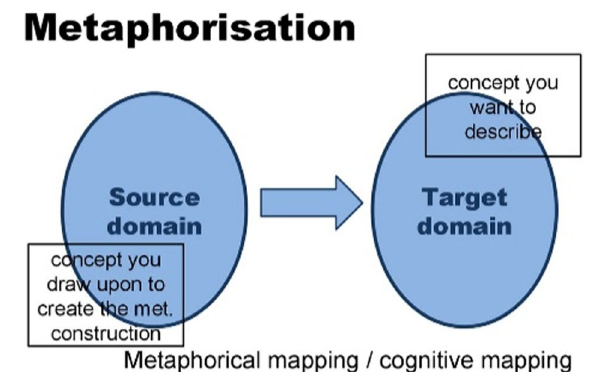
Fig. 6 Example of visual metaphor (Credits: SEIKO, Tempitalia; Creative